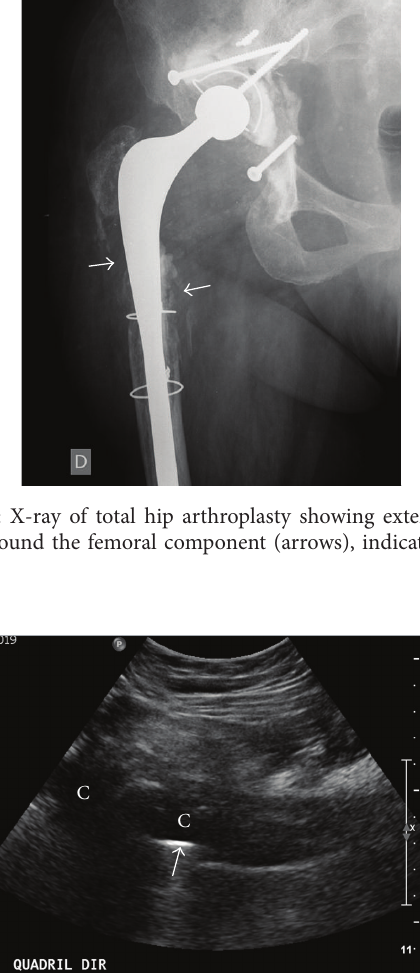
Figure 4: Ultrasound scan on a hip showing thick fluid collections (C) around the femoral component of the hip prosthesis